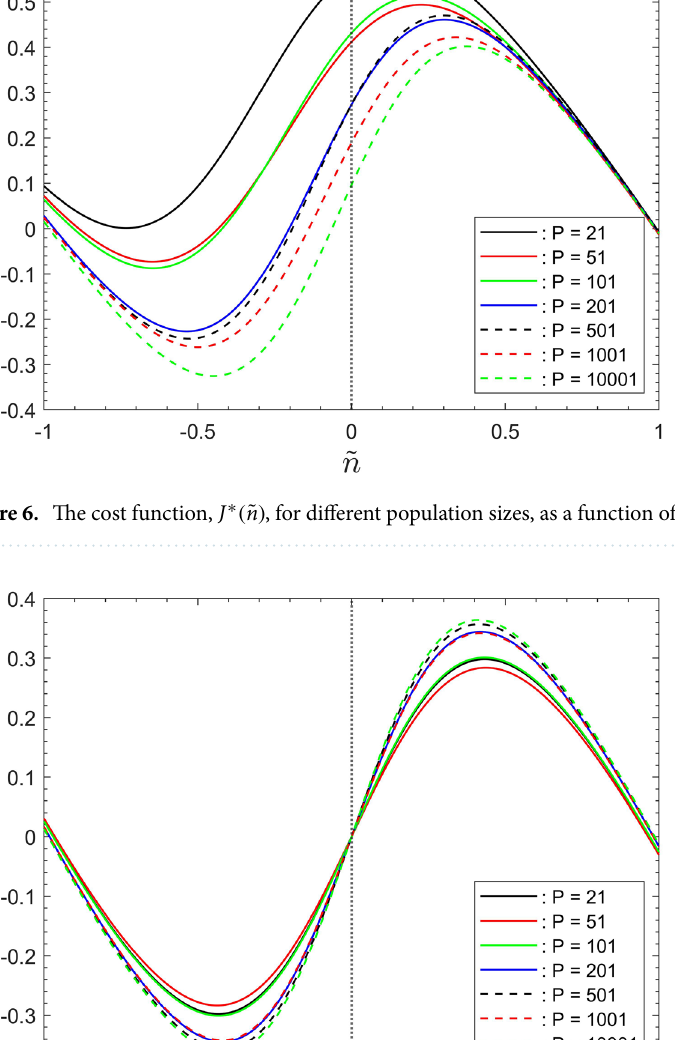
n ) , for different population sizes, as a function of the rescaled iterations step ˜